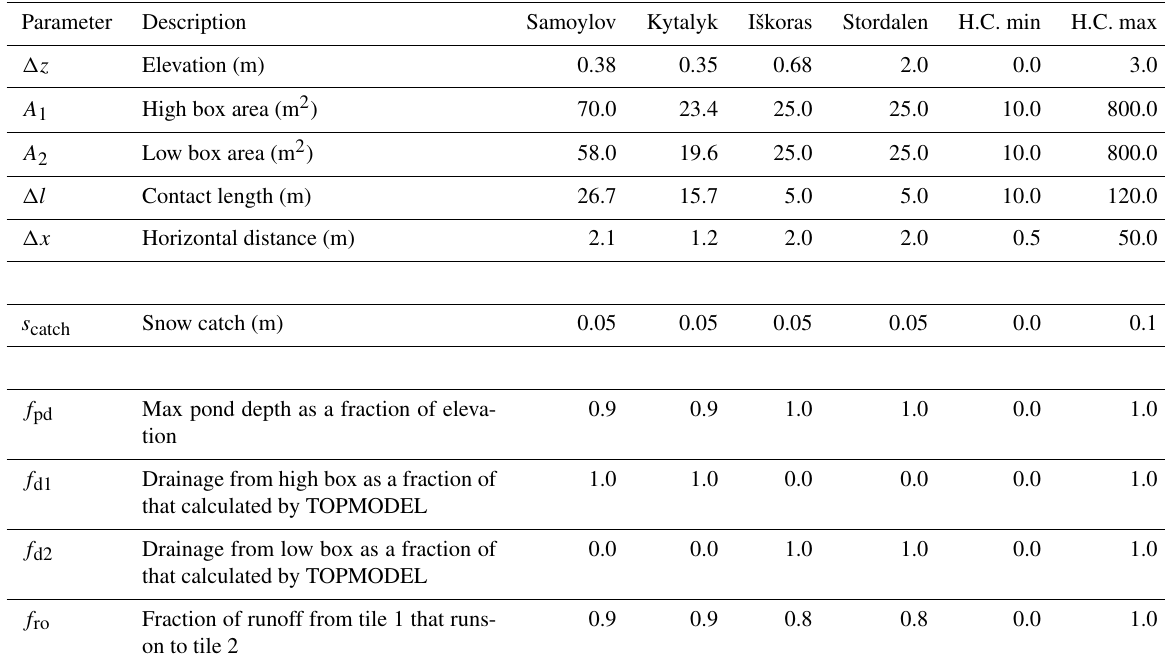
Table 2. Estimates of site-specific model parameters. H.C. min and max define the range over which the parameter was varied for the Latin hypercube sampling in the sensitivity study (Sect.